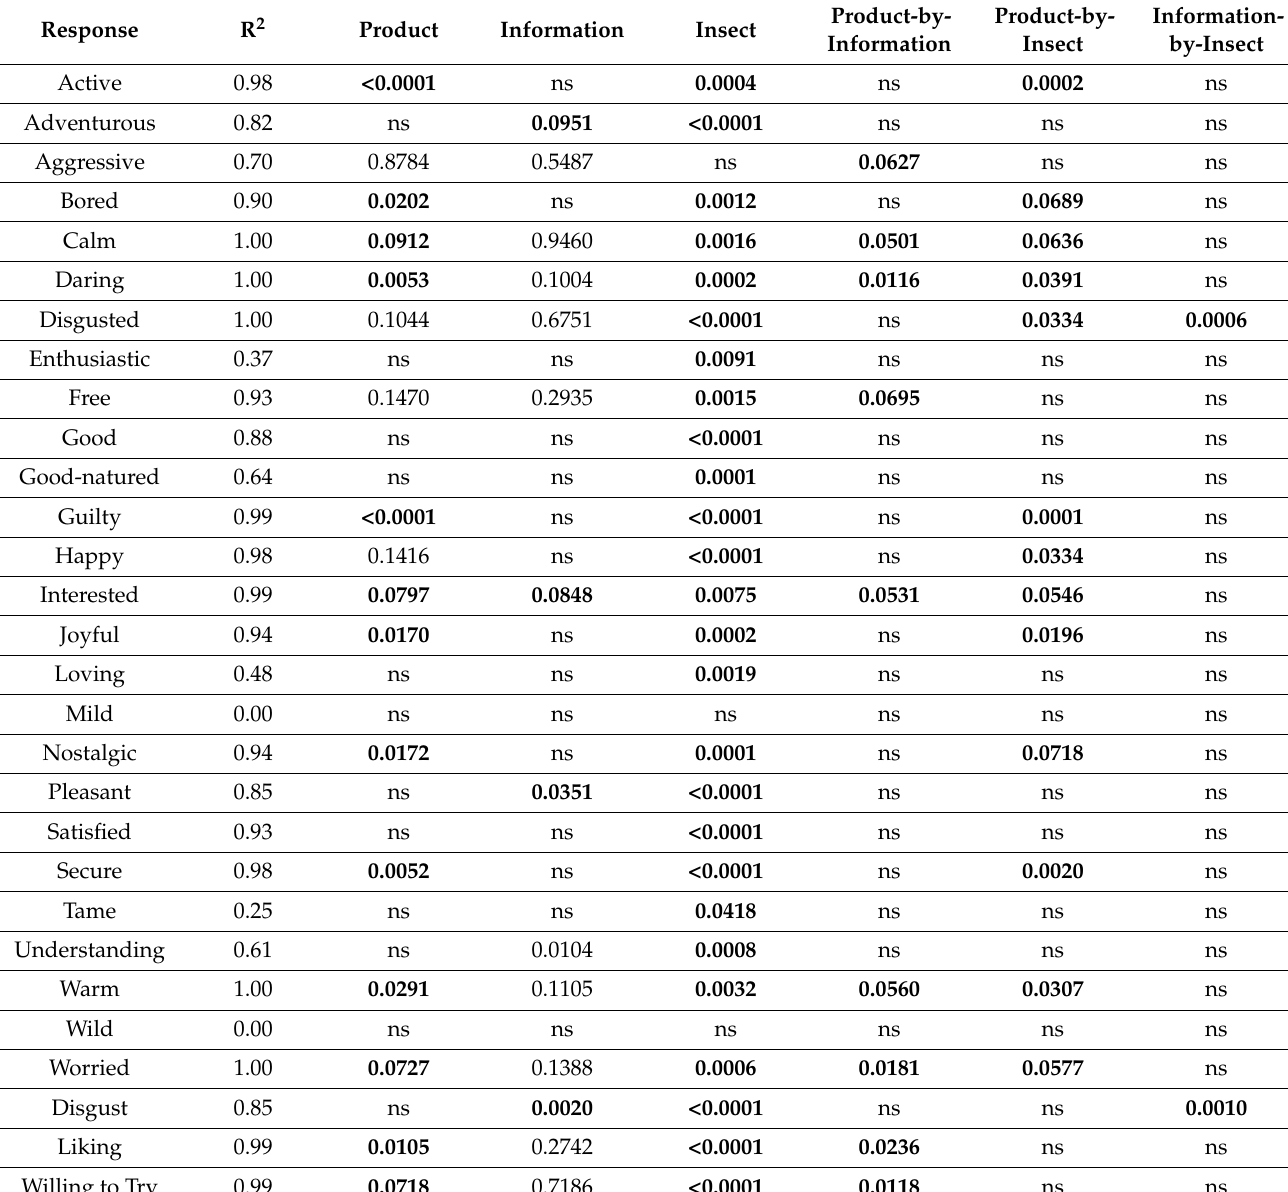
Table 3. Results from the ANOVA for all responses. For each main factor and two-way interaction p -values are presented (90% confidence level). The R 2 coefficient is indicated as well. The notation “ns” indicate a non-significant effect ( p ≤ 0.1). Significant factors are designated as